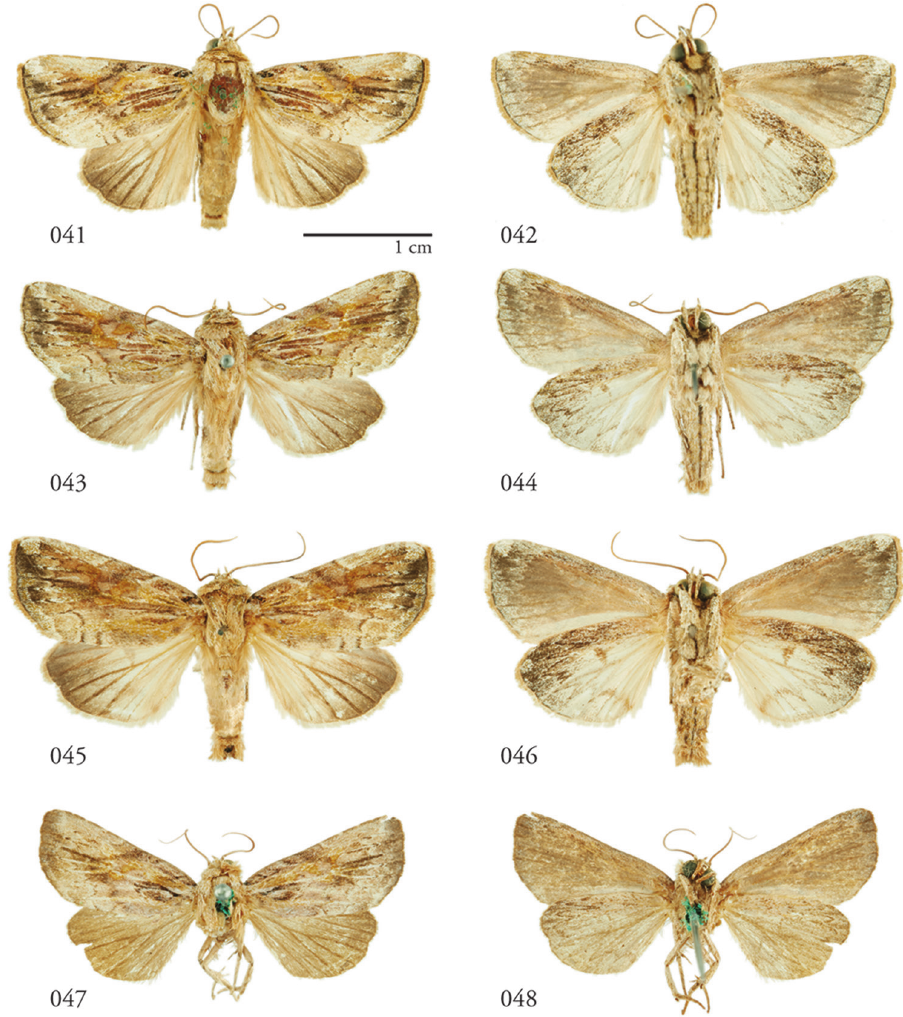
Figures 41–48. Lophomyra santista , habitus. Dorsal (left), Ventral (right). 41, 42 Holotype ♂ , Bra- zil, NHMUK01606195 43, 44 ♂ , Brazil, NHMUK01606196 45, 46 ♂ , Brazil, NHMUK01606198 47, 48 ♀ , French Guiana, USNM Dissection 148082, USNMENT01370318.